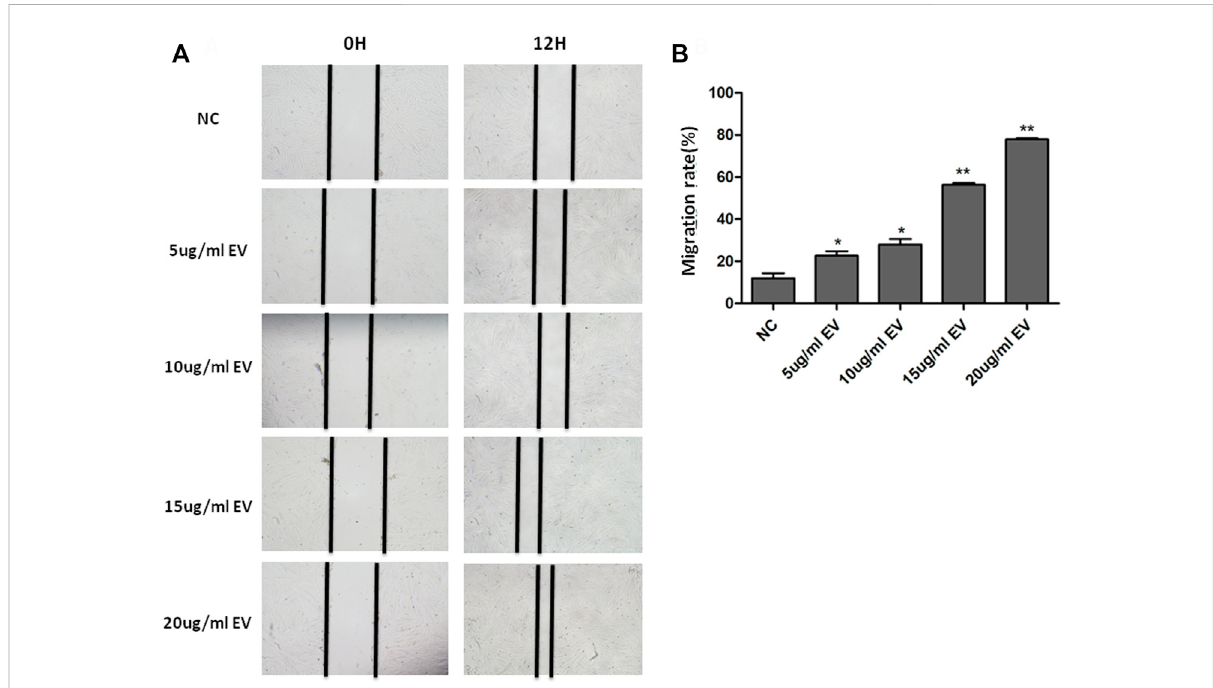
FIGURE 3 The effect of hMSC-Exo to human fi broblasts migration. (A) The microscopic features of human fi broblast with different concentrations of hMSC-Exo (5, 10, 15, and 20 μ g/ml). (B) The migration rate of human fi broblast scratch assay. * p < 0.05, * * p < 0.01, compared to NC group.